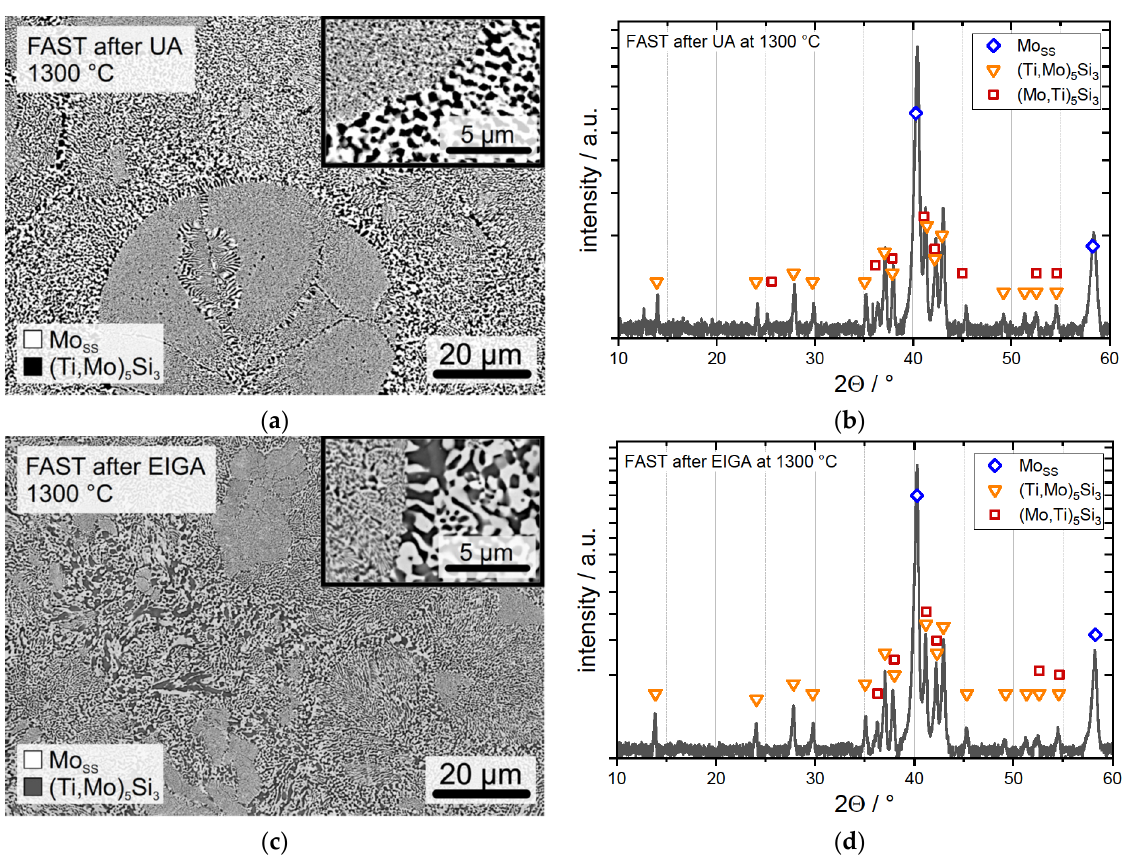
Figure 6. SEM BSE micrographs of the microstructures ( a , c ) and XRD patterns ( b , d ) of the consolidated materials from UA powder ( a , b ) and EIGA powder ( c , d ).